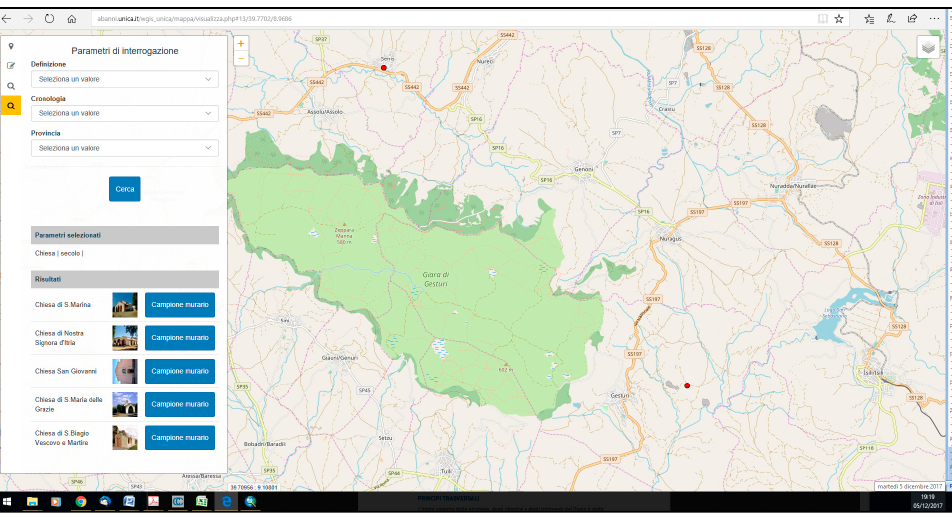
Figure 10. Query Result.